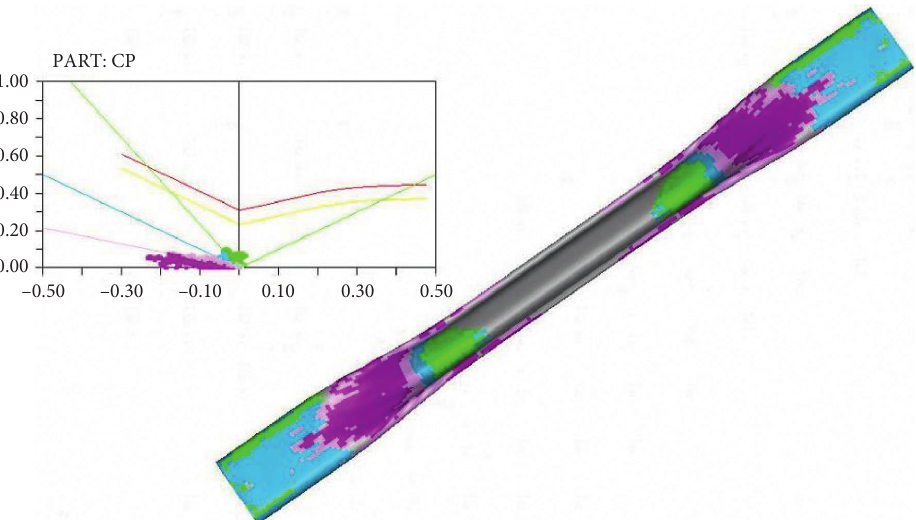
Figure 12: FLD of torsion beam preform.